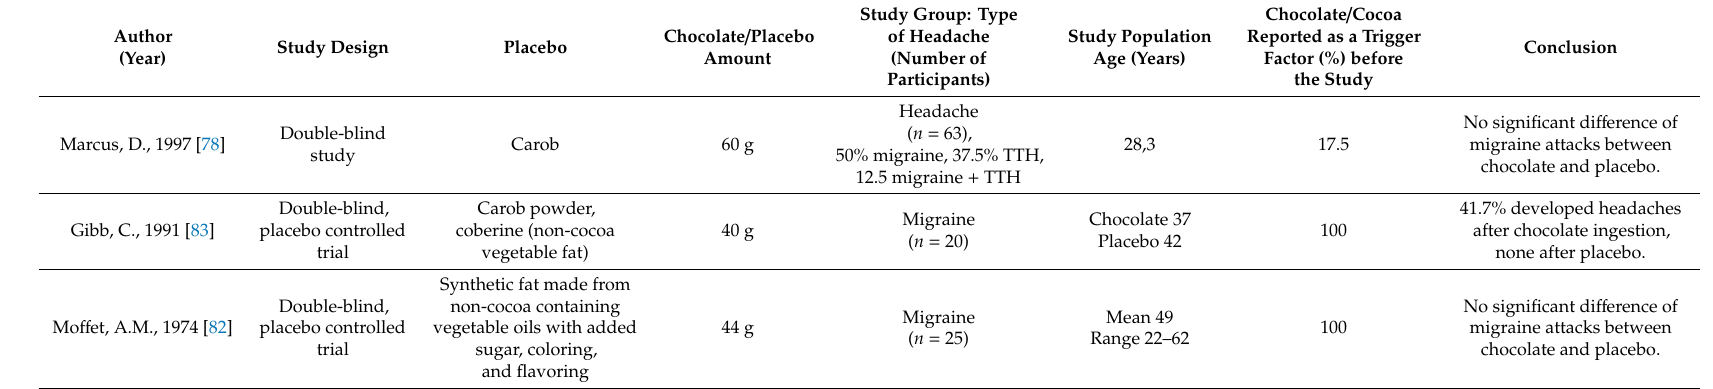
Table 2. Overview of provocative studies evaluating the e ff ect of chocolate on migraine attacks. Abbreviations: TTH–tension type